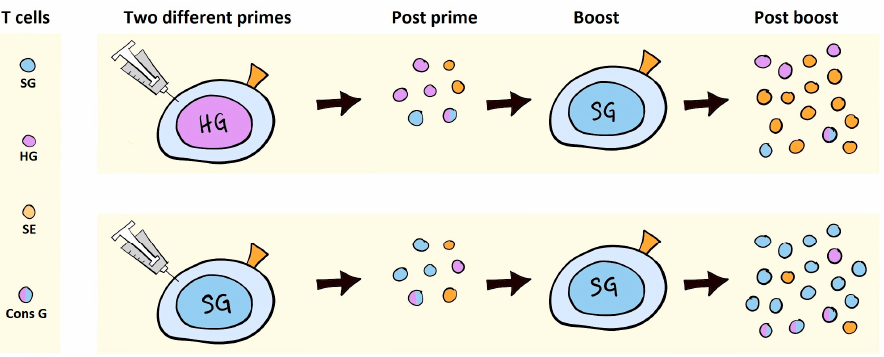
Figure 5. Graphic illustration of the results obtained in Andersson et al. 2016 [46]. The left panel depicts the T cells with specificity for SIV Gag (SG), HIV Gag (HG), SIV Env (SE), or with dual specificity for HIV and SIV Gag (Cons G). The priming expands the T cells with relevant specificities (mid-left). Booster immunization results in the expansion of SIV Env-specific T cells when heterologous gag is applied, and the expansion of SIV gag, including cross-reactive Gag-specific T cells, when a homologous Gag immunization is applied. Thus, in the face of Env antigen competition, boosting of cross-reactive Gag-specific T cells is inhibited.